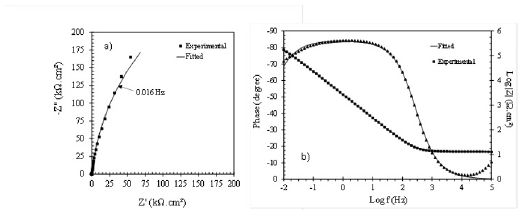
Figure 5. EIS results for the AISI 409 stainless steel after immersion for 24 h in 0.1 M NaCl solution at room temperature: a) Nyquist,